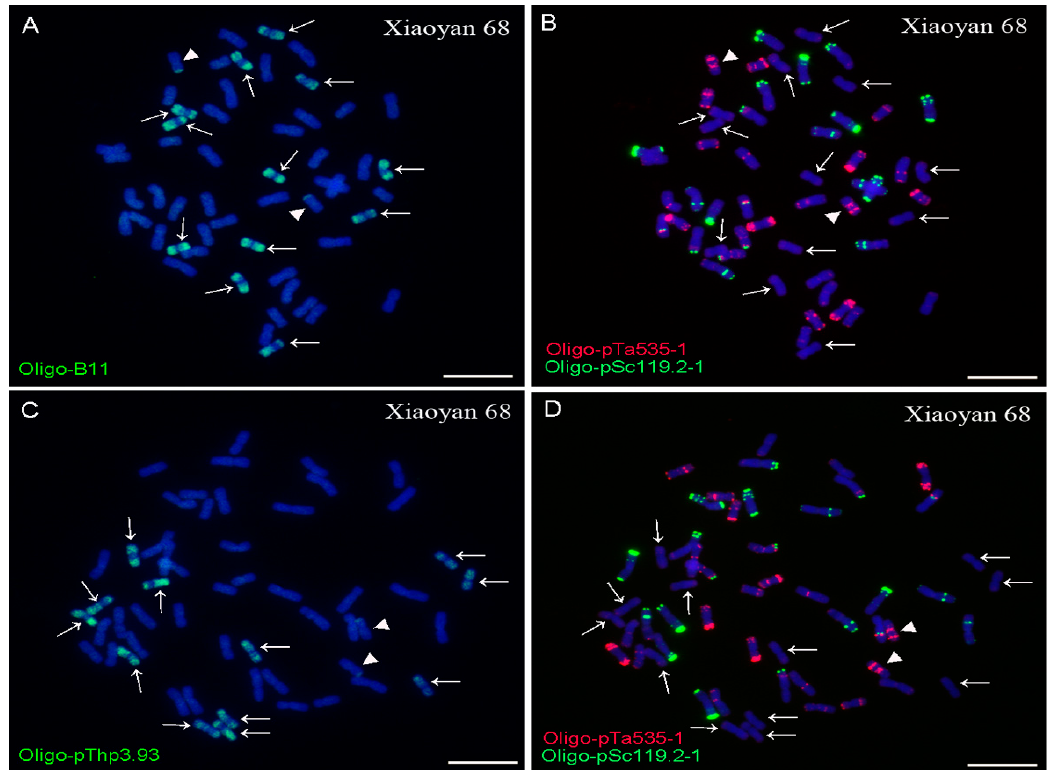
Figure 1. ND-FISH analysis of root tip metaphase chromosomes of Xiaoyan 68 using the Oligo-B11 (green), Oligo-pThp3.93 (green), Oligo-pTa535-1 (red), and Oligo-pSc119.2-1 (green) as probes. ( A ) and ( B ) are the same cell, and ( C ) and ( D ) are the same cell. Arrows indicate the Th. ponticum chromosomes that carry signals of Oligo-B11 ( A ) and Oligo-pThp3.93 ( C ). Triangles indicate the wheat- Th. ponticum translocation chromosomes TTh-4DS · 4DL. Chromosomes were counterstained with DAPI (blue). Scale bar: 10 μ m.